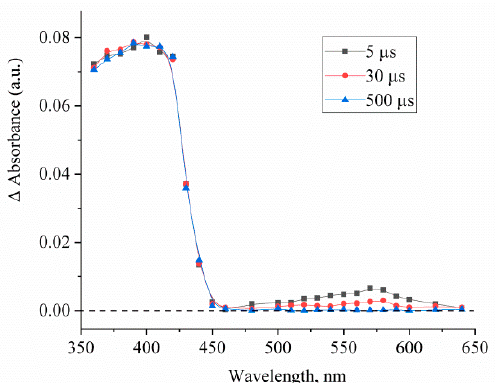
Figure 4. Difference photoinduced absorption spectra of deoxygenated solution of compound 1 measured at 5, 30, and 300 μ s after the laser pulse. The concentration of compound 1 is 5 × 10 − 5 mol/L.